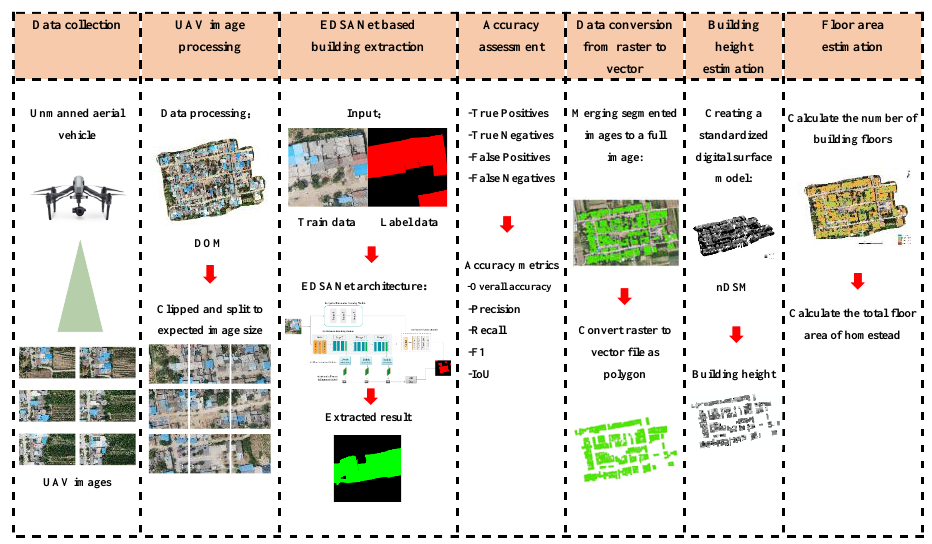
Figure 3. Flowchart of building extraction and floor area estimation in this research.